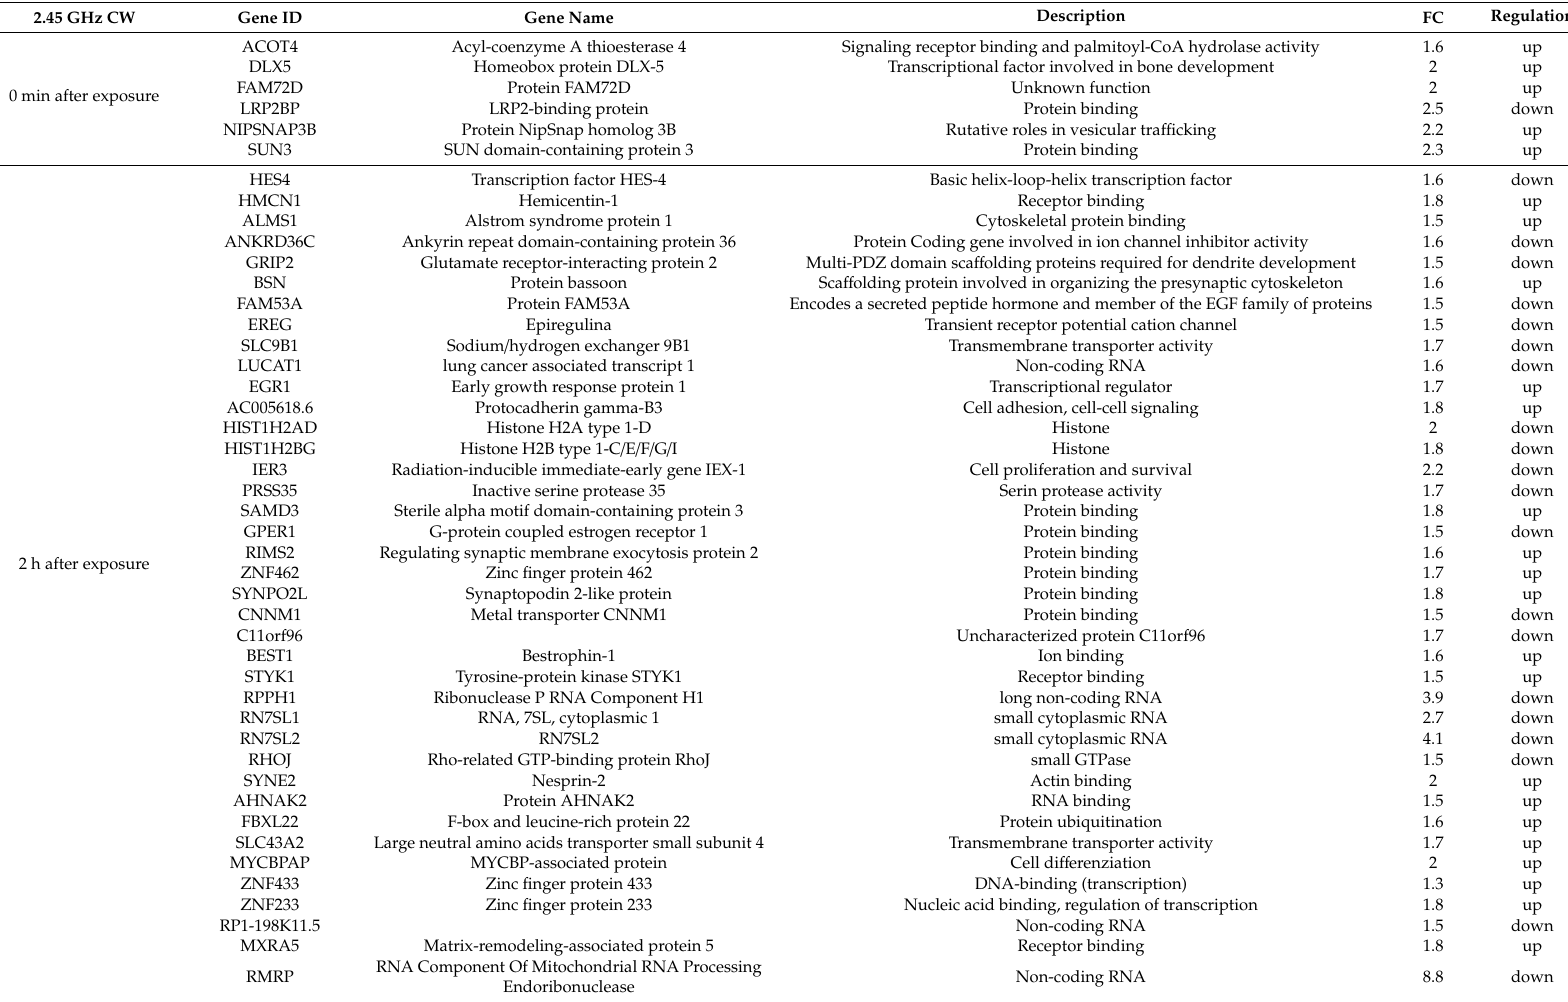
Table 2. List of genes di ff erentially expressed between exposed and sham samples after exposure to 2.45 GHz CW. The table includes gene name, gene function, fold change (FC), and